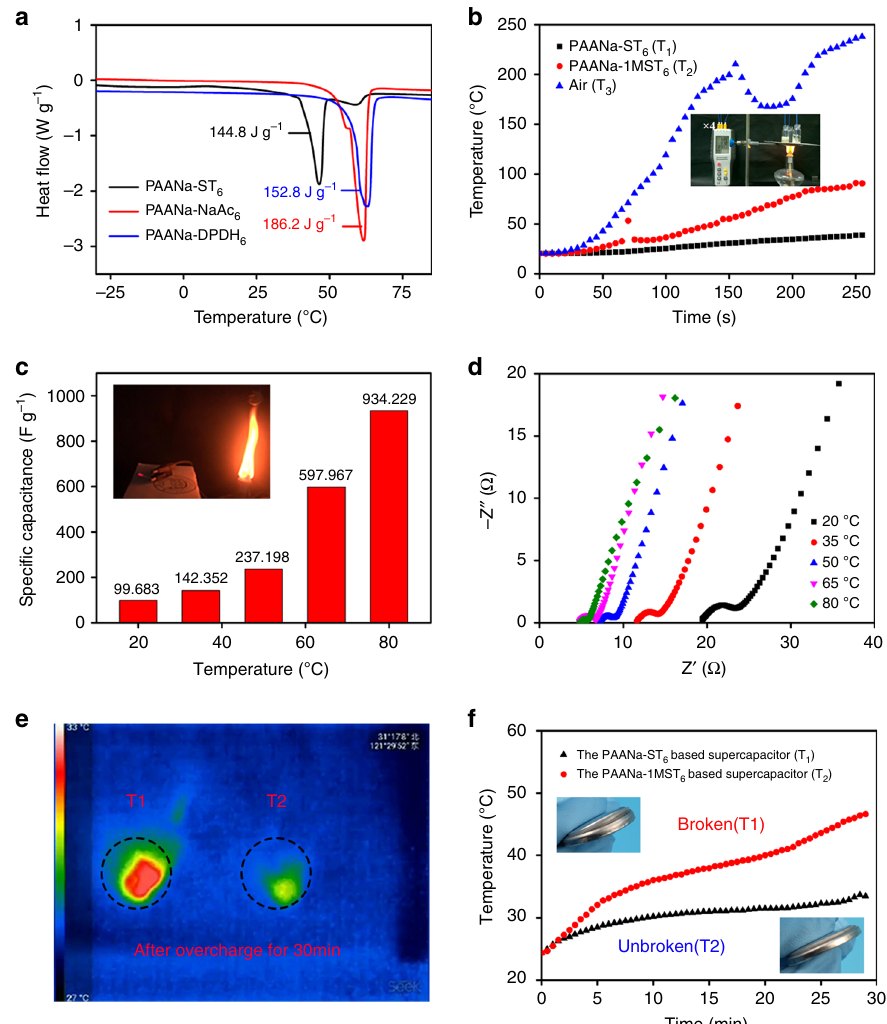
Fig. 6 Thermal-shock resistances of the PCCE-based supercapacitor. a DSC curves of different PCCEs. b Temperature variation comparison of different PCCEs in the fi re. c Speci fi c capacitance of the PAANa-ST 6 -based supercapacitor in the range of 20 to 80°C. Illustration: optical image of the PAANa- ST 6 -based supercapacitor in fi re. d Nyquist plots of the PAANa-ST 6 -based supercapacitor in the range of 20 – 80°C. e Thermal imaging pictures of the PAANa- ST 6 - and PAANa-1MST 6 -based supercapacitor after overcharge for 30min at a current density of 5Ag − 1 . f Temperature variation comparison of PAANa-ST 6 - and PAANa-1MST 6 -based supercapacitor. Illustration: optical image of the PAANa-ST 6 - and PAANa-1MST 6 -based supercapacitor after